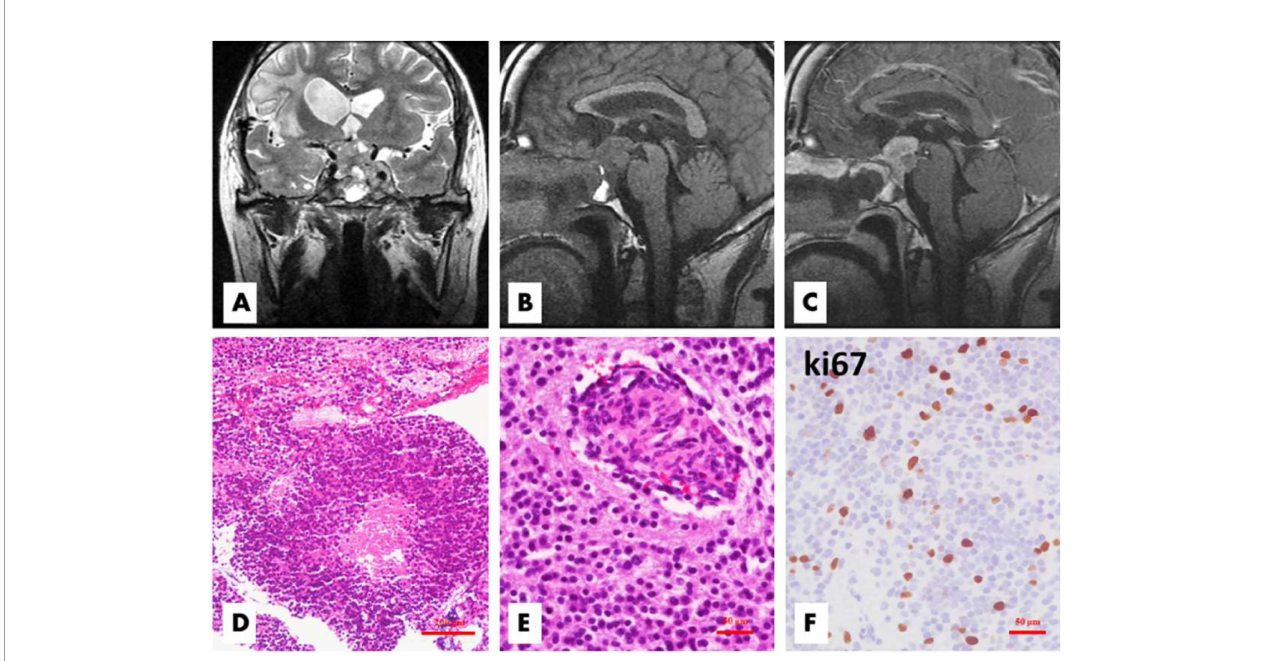
FIGURE 2 | Patient 1 relapsed 50 months after the fi rst surgery. The tumor located in the sellar and suprasellar regions demonstrated inhomogeneous hyperintensity on coronal T2WI, and the bilateral cavernous sinuses were involved (A) . On sagittal T1WI images, the lesion exhibited inhomogeneous hypointensity and irregular margins (B) , with signi fi cant inhomogeneous enhancement on enhanced T1WI (C) . Histologically, there were some atypical or anaplastic features, including focal necrosis (D , H&E, ×100 ) and microvascular proliferation (E , H&E,×200 ) , with a high Ki-67 index (F , ×200 )